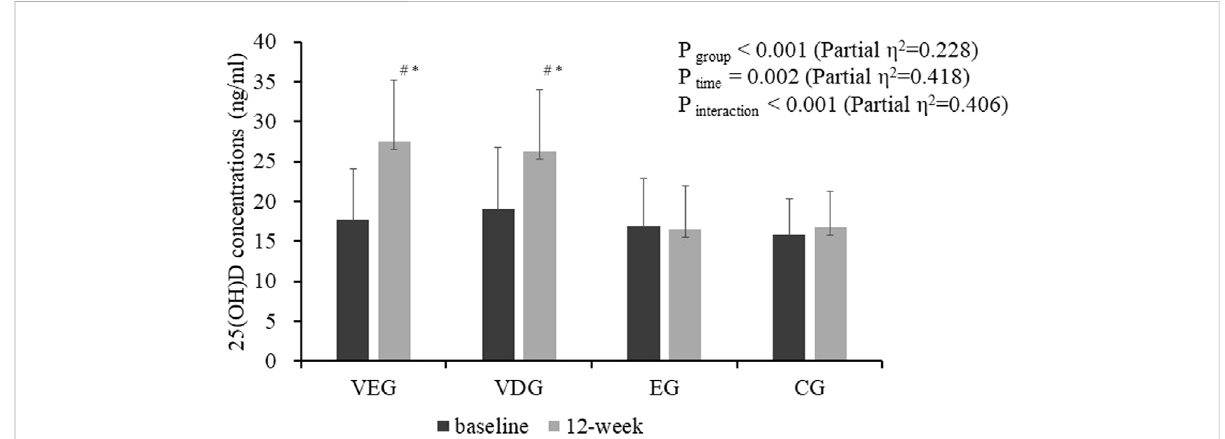
FIGURE 2 Effect of vitamin D supplementation on serum 25(OH)D concentrations in 59 patients with type 2 diabetes mellitus. Values are expressed as mean ± standard deviation. VEG, vitamin D combined exercise intervention group; VDG, vitamin D intervention group; EG, exercise intervention group; CG, control group. Two way repeated-measures ANOVA was used to determine the effect of time and group on serum 25(OH)D. # , p < 0.05 vs. the baseline within group; *, p < 0.01 vs. exercise or control group at the same time